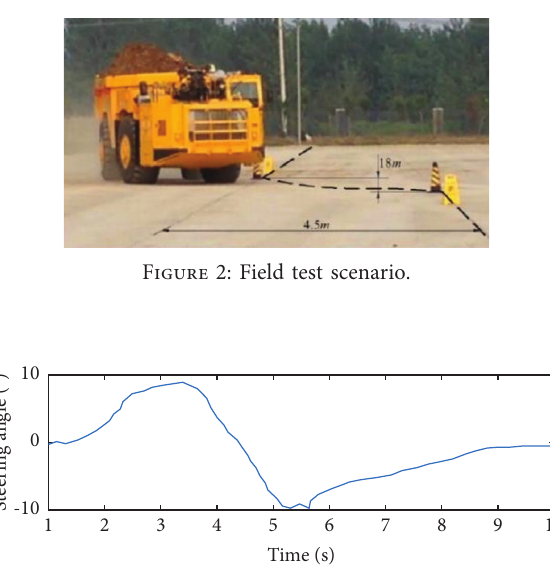
Figure 3: Input steering angle in the field test.